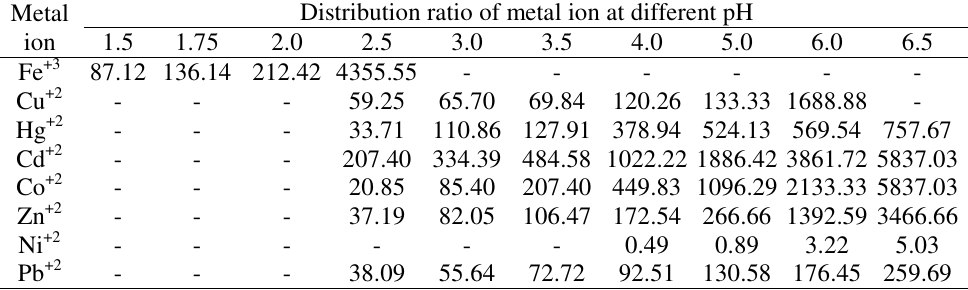
Table 7 . Distribution ratio D a of various metal ion as a function of the pH b by 2, 4-DHBOF- I terpolymers